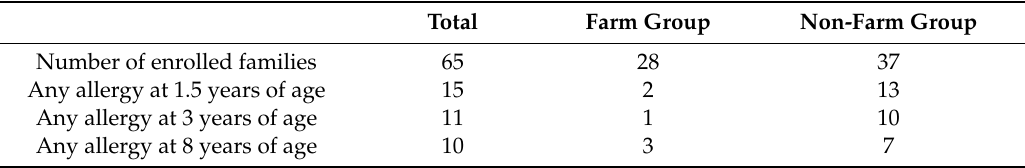
Table 3. Allergy distribution in the FARMFLORA